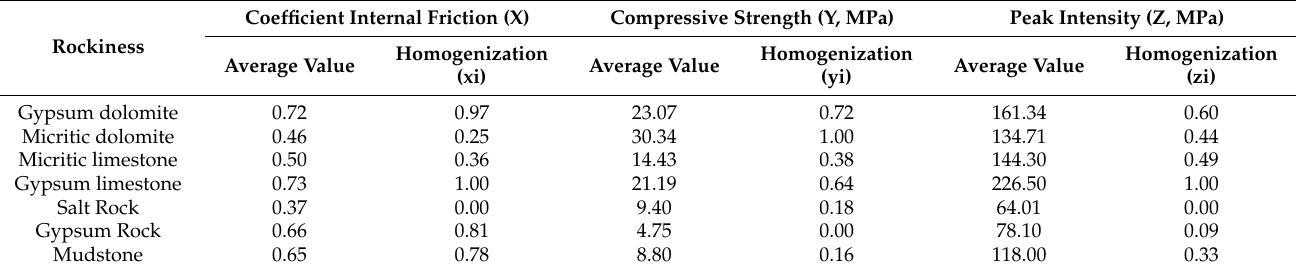
Table 3. Homogenization table of each mechanical parameter.